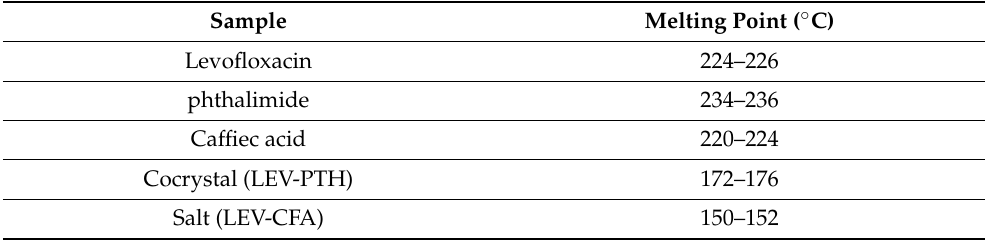
Table 1. Melting point of raw materials and